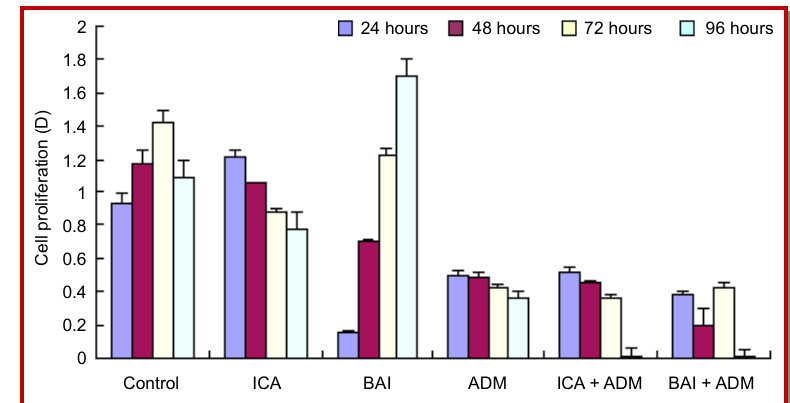
Figure 2: Influence of different time of ICA, BAI, ADM on HepG2 cells proliferation; n=3